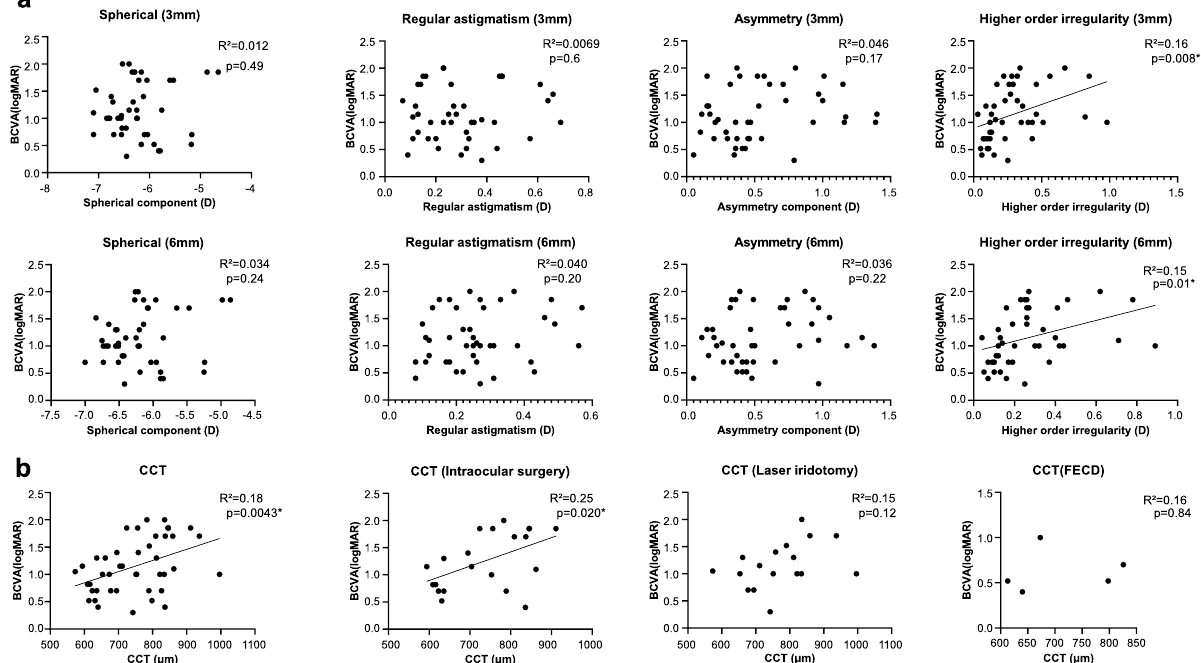
Figure 4. Linear regression between ( a ) each Fourier component of the posterior cornea and logMAR best corrected visual acuity (BCVA), as well as ( b ) CCT and logMAR BCVA. Significant associations are seen with higher-order irregularity in the central 3 mm zone (R 2 = 0.16, p = 0.008) and the central 6 mm zone (R 2 = 0.15, p = 0.01). A significant association is seen between CCT and logMAR BCVA (R 2 = 0.18, p = 0.0043) With subgroup analysis that divides BK etiologies into three groups (intraocular surgery, laser iridotomy and FECD), only CCT in the intraoperative surgery group significantly correlates with BCVA (R 2 = 0.25, p = 0.020). Regression lines are drawn for graphs with statistical significance (*p <